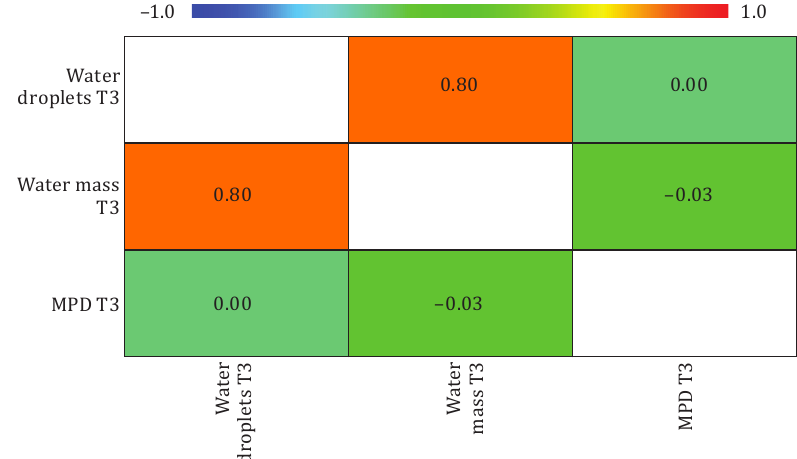
Figure 16. Pearson product-moment correlations between each pair of variables for Test Track 3